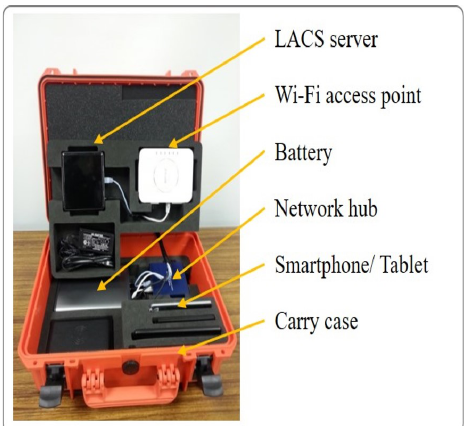
Figure 1. LACS prototype.